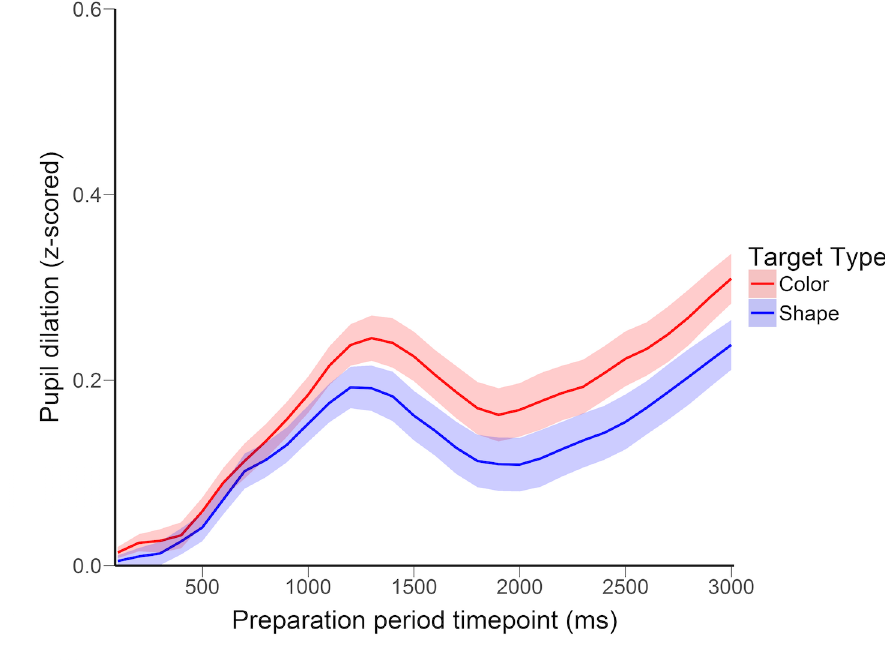
Fig 5. Pupil dilation across the preparation period in Experiment 2. Error bandsdepict standarderror of the mean color vs shape difference scores.